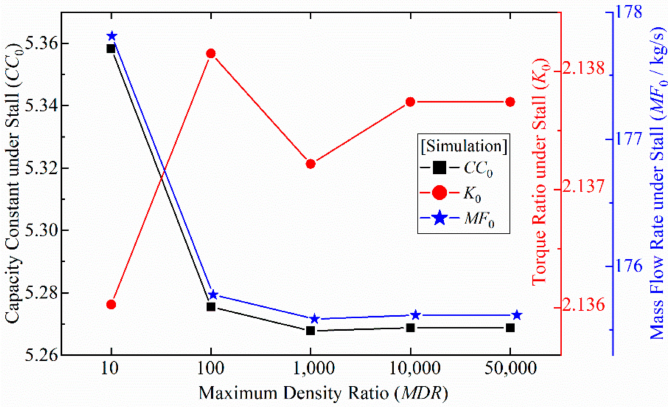
Figure 31. Capacity constant, torque ratio, and mass flow rate of torque converter at stall under various maximum density ratios.